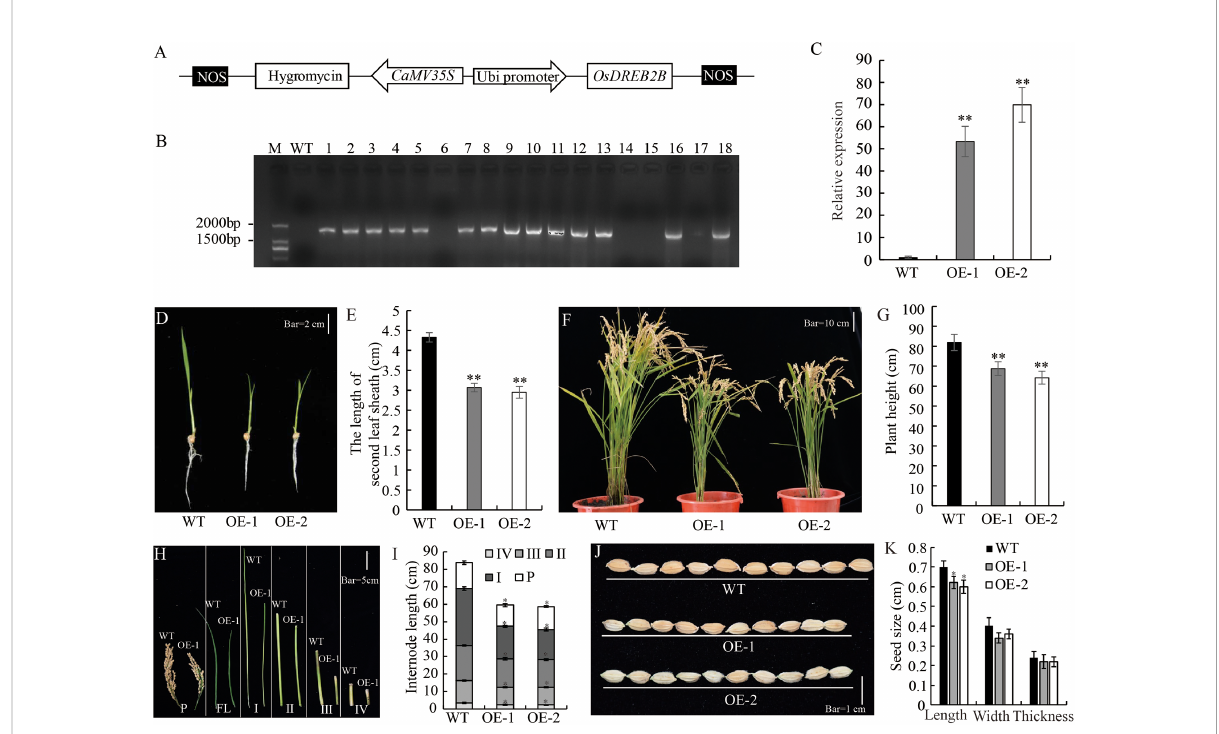
FIGURE 2 Development and morphology of OsDREB2B-OE rice. (A) Schematic representation of OsDREB2B plant expression vector. OsDREB2B was expressed under the control of maize ubiquitin (Ubi) promoter, and the hygromycin (hgy) gene was under the control of 35S promoter as a selection marker in rice. (B) PCR analyses for T 0 transgenic rice using construct-speci fi c primers. M, marker; WT, Kitaake; 1~18, independent transformants of T 0 generation. (C) The expression of OsDREB2B were analyzed by qRT-PCR in WT and DE. The data was presented as the mean ± SE values (n = 3) from two independent experiments. (D, E) Whole-plant morphology of the OE lines and the WT at the seedling stage. Bar = 2 cm. (F, G) Whole plant morphology of OsDREB2B -OE plants and the WT at maturity. Bar = 10 cm. (H) Panicles and internodes of the main culms of OE-1 (right) and the WT (left). Bar = 5 cm. (I) Internode lengths of OE lines and the WT. (J) Seed morphology. Bar = 1 cm. (K) Seed size of the OE lines and the WT. Single asterisk indicates signi fi cant differences at P ≤ 0.05 compared with the WT and double asterisks indicate signi fi cant differences at P ≤ 0.01 compared with the WT in Student ’ s